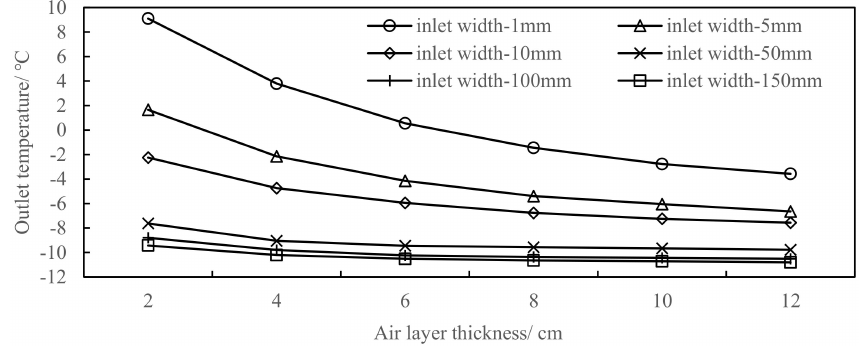
Figure 5. The outlet temperature variation with the thickness of the air layer.